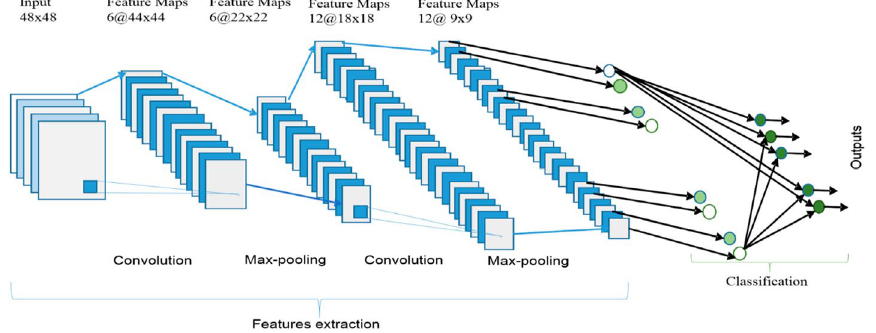
Fig. 14 Feature extractors and classifier parts of CNN